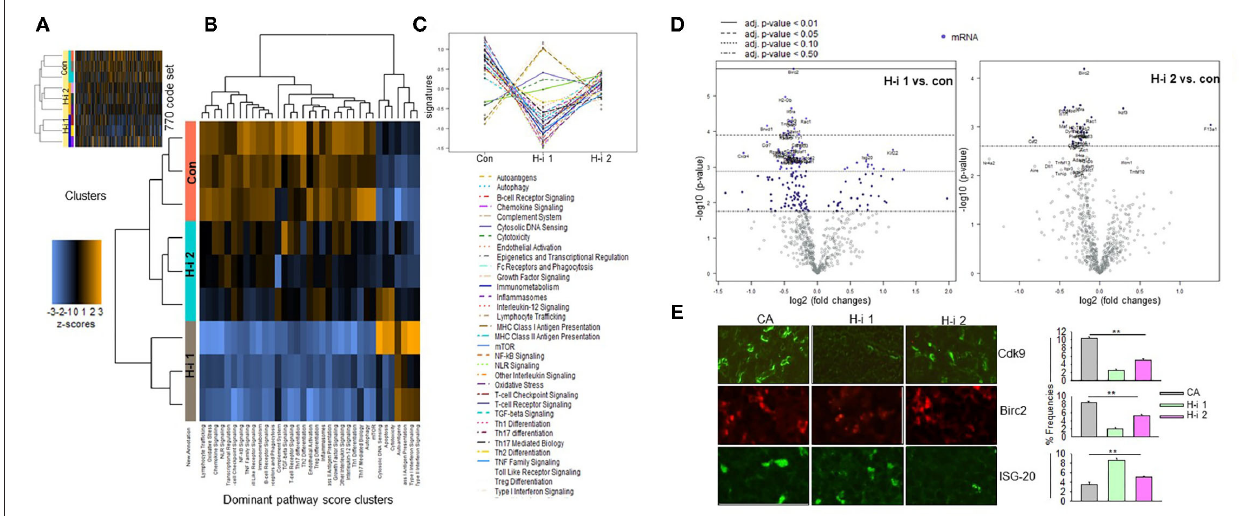
FIGURE 7 | nCounter gene expression panel. Expression profiling of autoimmune-associated genes using the NanoString nCounter system. (A) Heatmap shows expression intensities of 770 autoimmune-associated genes clustered in rows (blue reflecting lower and brown showing higher abundance mRNAs). The columns represent pooled DMSO controls (lanes 1–3) and H2- (lanes 4–6) and H1- (lanes 7–9) treated spleen mRNA samples from EAMG mice ( n = 5 per group, samples pooled) 4 weeks post 3rd treatment with HDAC-i. (B,C) Pathway scores. Pathway heatmap score and score plot reflect an overview of the dominant pathways affected by treatments of HDAC1 (H1) or HDAC2 (H2) relative to the baseline solvent controls (Con). Pathway average scores (shown by lines) represent the gene expression profile of each sample compressed into a small set of pathway scores. These scores are placed using the first principal component of each gene set data; in general, an increased score corresponds to increased expression. (D) Volcano plot depicts the distribution of the estimated log fold change or differential expression of each gene relative to the baseline or controls. Highly statistically significant genes are above the horizontal lines ( p -value thresholds), and differentially manifested highly-repressed or highly-expressed genes are on the left or right sides, respectively. Up to 20 of the most statistically significant genes are represented by colored dots in the plot. Highly up/downregulated genes in the volcano plot are described in Tables 1 , 2 . (E) Shown are the fluorescence microscope captured images of spleen sections from DMSO, HDAC-i 1, and HDAC-i 2 treated EAMG mice. The images are representative views from the sections stained with Cdk9, IAP-1, and ISG-20 specific Alexa-conjugated Abs. A semi-quantitative assessment of fluorescence-deposits indicates relative protein abundance in samples (bar graphs). Result is representative of three independent experiments. Vertical bars represent standard error, n = 3 per group. ** P <